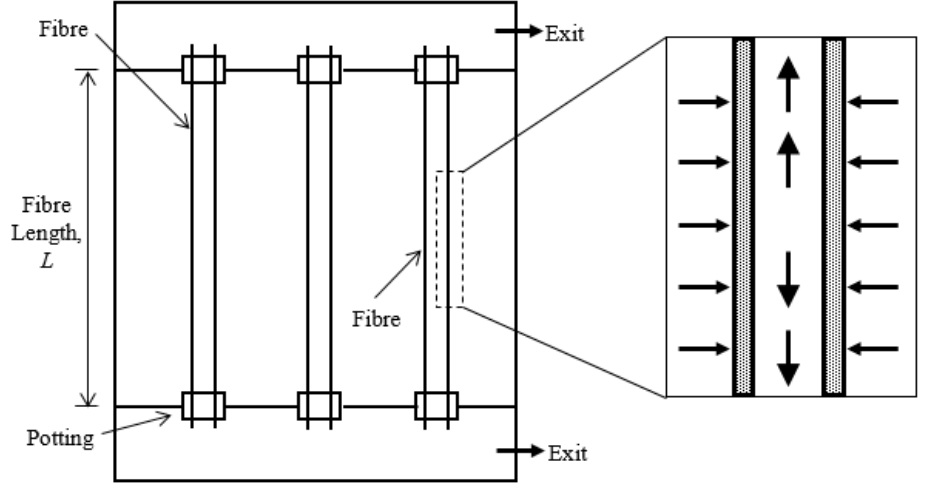
Figure 2. Simplified illustration of fibre layout within housing (double-end configuration). Arrows indicate flow of water within system.